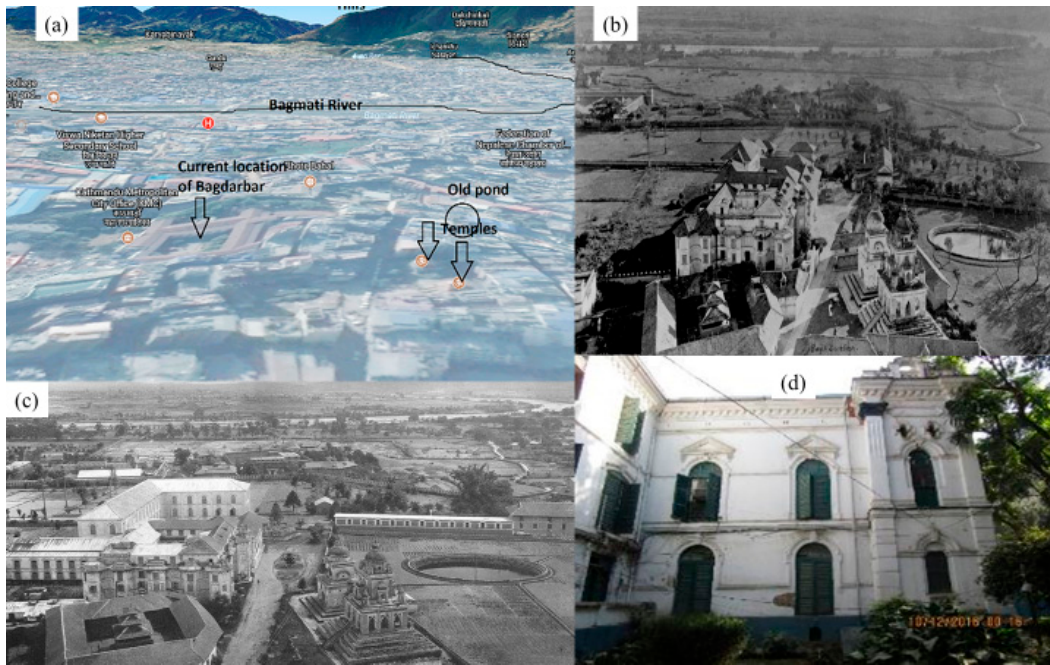
Figure 1. ( a ) Location of Bagh Durbar ( b ) old Bagh Durbar (picture credit: Madan Pustakalay, Lalitpur), ( c ) changes in construction and neighborhood in Bagh Durbar area (picture credit: Madan Pustakalay, Lalitpur), ( d ) present day facade of Bagh Durbar.